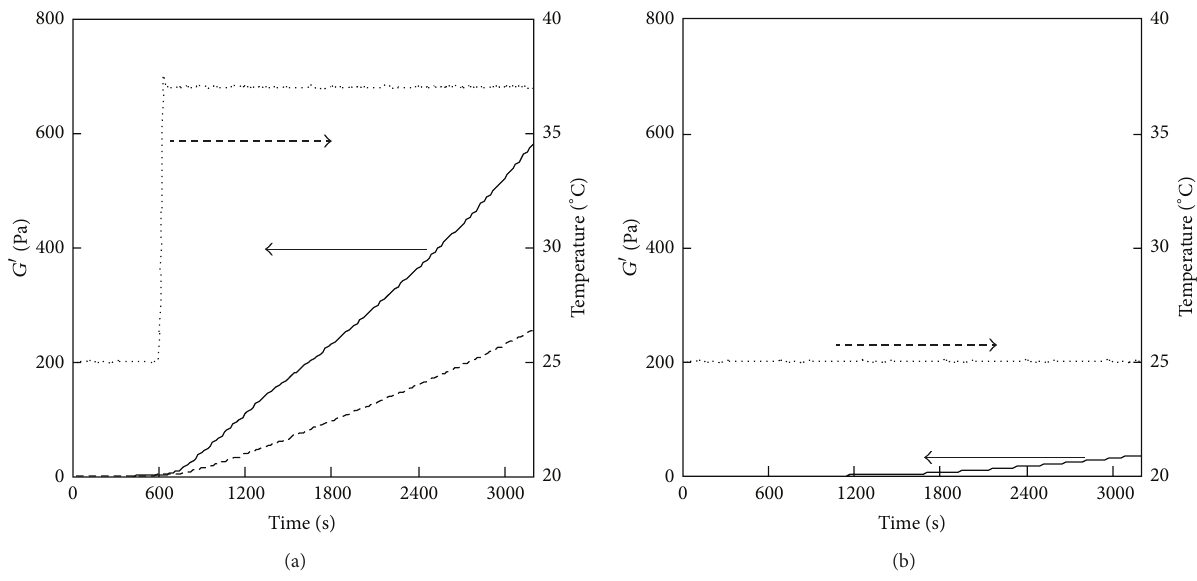
Figure 9: (a) Storage modulus ( G 󸀠 ) of chitosan solutions measured by a temperature-responsive gelation test. Solid line, 0.5% chitosan/5mM genipin solution; dotted line, 0.5% chitosan/6 mM GA solution. (b) Storage modulus ( G 󸀠 ) of the 0.5% chitosan/5mM genipin solution measured by a fluidity test at a constant temperature of 25 ∘